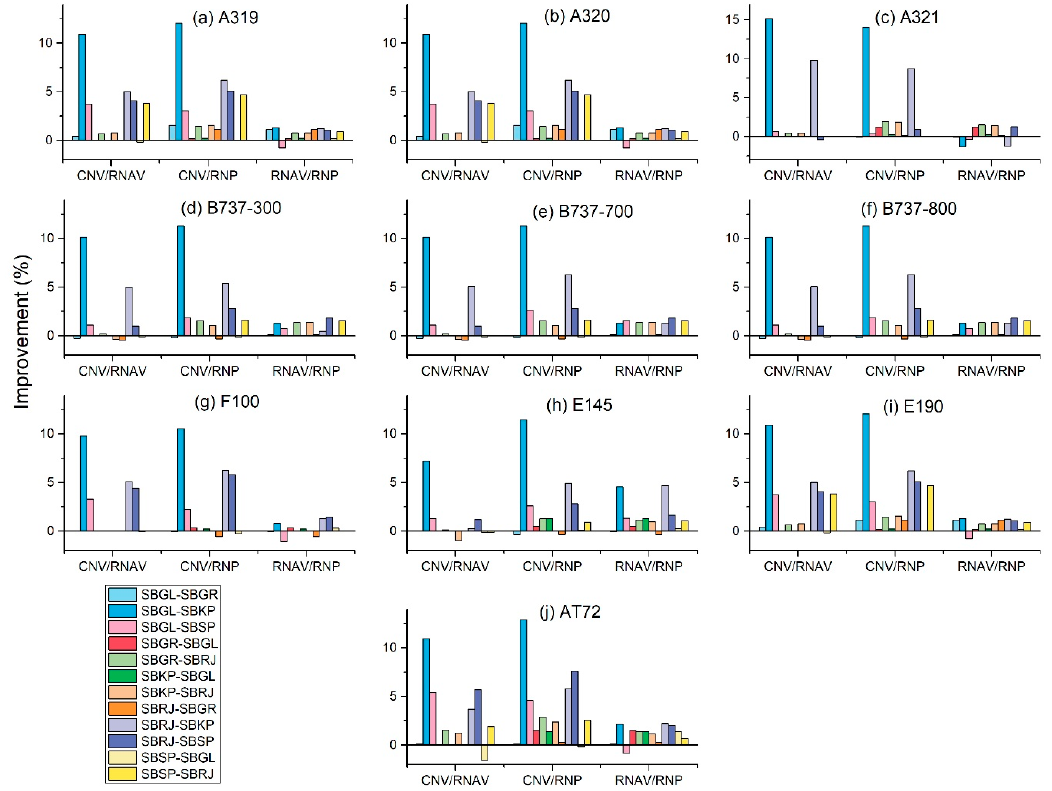
Figure 5. Case 1 route percentage improvement by aircraft. ( a ) A319; ( b ) A320; ( c ) A321; ( d ) B737-300; ( e ) B737-700; ( f ) B737-800; ( g ) F100; ( h ) E145; ( i ) E190; ( j ) AT72. ( f ) B737-800; ( g ) F100; ( h ) E145; ( i ) E190; ( j )